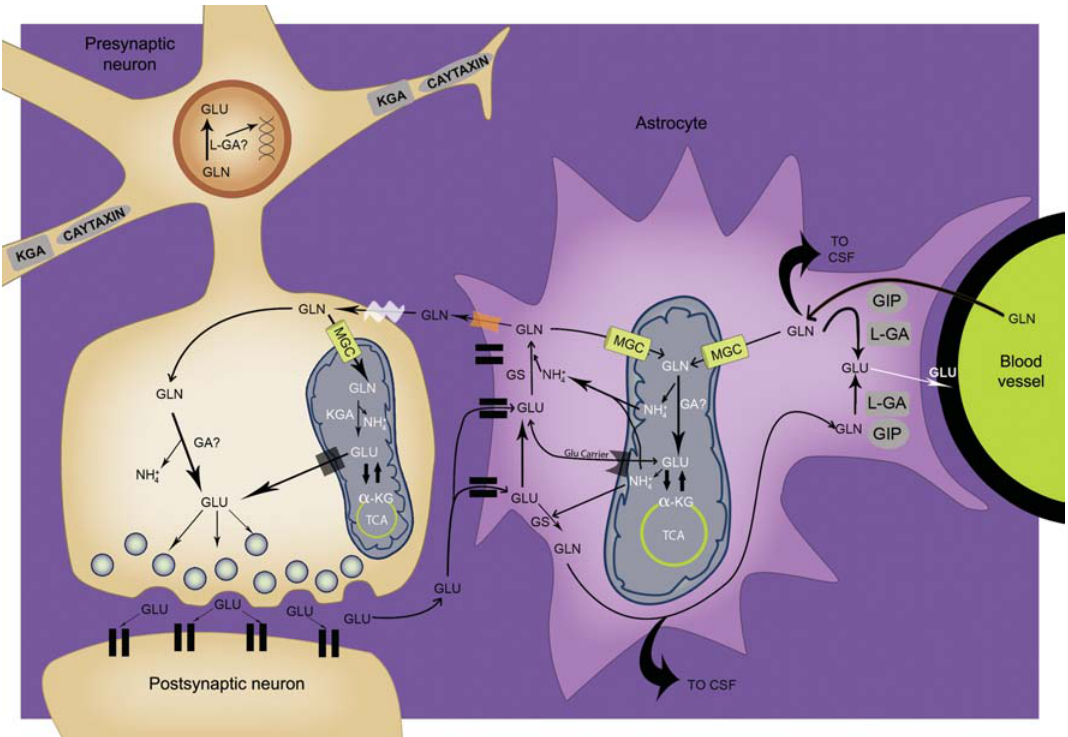
Figure 2 Schematic illustration of the Glu/Gln cycle between neurones and astrocytes at the tripartite synapsis. This is a simplified model highlighting the main functions of GA isozymes, even if not enough evidence exists for a particular task. In the latter case, a question mark denotes ‘not enough evidence’. For example, in neuronal nuclei the presence of L-type GA isoform has been demonstrated; however, the nuclear function of this GA has not been fully ascertained. Two alternative functions appear: regulation of the Gln/Glu levels or transcriptional regulation (arrow pointing toward DNA). The relative contribution of K-type and L-type isoforms in the synthesis of the neurotransmitter Glu pool remains to be clarified. In neuronal body, Gln is converted to Glu by mitochondrial KGA, whereas the existence of a cytosolic GA, which could contribute to the Glu transmitter pool, has not yet been confirmed. Synaptic Glu is primarily taken up by astrocytes, mostly converted to Gln by GS in the cytosol, and then cycled back to neurones where GA regenerates the transmitter Glu. Exogenous Glu can be transported to glial mitochondria and converted to a -KG by GDH or transamination, followed by oxidation into the TCA cycle. Astroglial Gln can be exchanged with blood. Some Gln can be oxidatively degraded by astrocytic GA and TCA cycle after being transported into mitochondria through the uncharacterized MGC; the ammonium generated might be channeled to cytosolic Gln synthesis. Experimental evidence supports L-type GA expression in astrocyte (evidence is lacking for KGA). L-type GA and GIP can interact in vivo and astrocytes are a likely anatomic substrate for their coupling in brain. The colocalization of GIP and L-type GA in astrocytes, particularly in perivascular end feet surrounding capillaries, might be related to the regulation of the vascular tone. The detailed anatomy of synapses, astrocytes and blood vessels is not portrayed. MGC, itochondrial ln arrier; CSF, cerebrospinal fluid; L-GA: L-M G C type GA (GAB or LGA isoforms); KGA, K-type long GA isoform; a -KG, a -ketoglutarate.